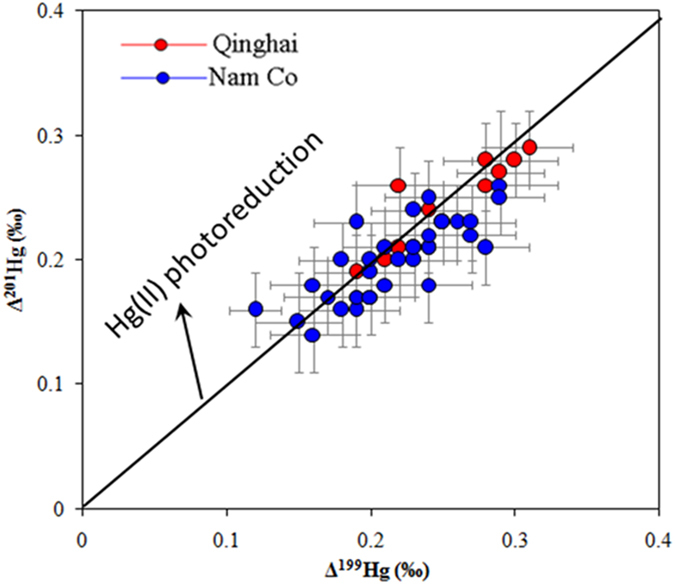
Relations between ∆ 199Hg and ∆ 201Hg in sediments of Lake Qinghai and Nam Co.